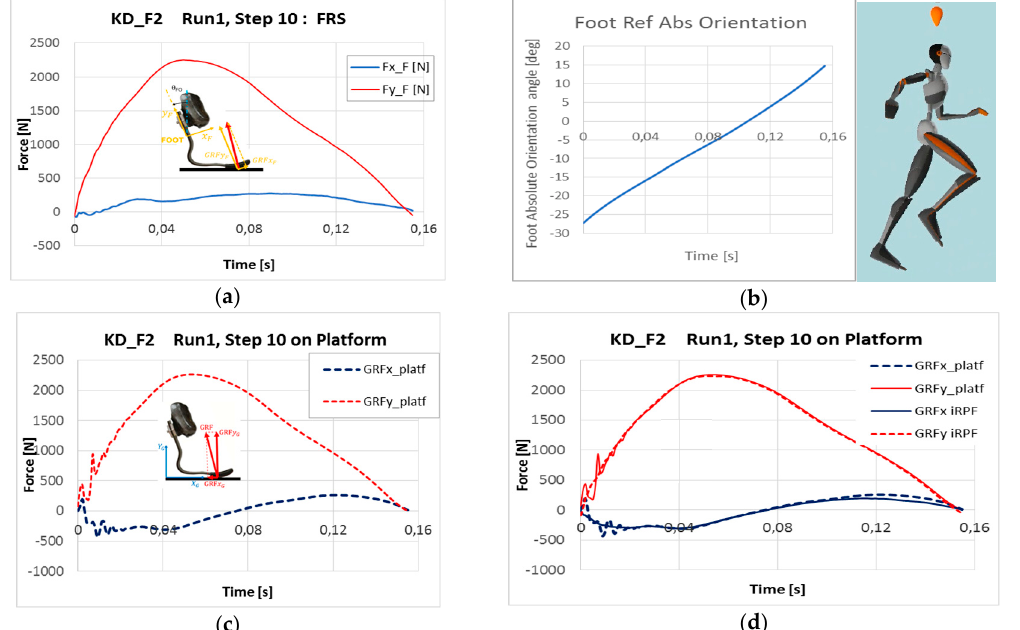
Figure 5. Dynamic validation of the iRPF by comparing GRF measured with the force platform and with the iRPF during a running test of athlete KD2: ( a ) Force components in the Foot reference system, collected from the iRPF, ( b ) absolute orientation angle of the Foot reference system obtained by the Xsens Moven suit during the step over the force platform, ( c ) GRF measured by the Kistler force platform at the passage of the athlete. ( d ) Comparison of X and Y GRF components between the force platform measurement (dotted) and the iRPF loads resolved in the Global Reference Frame.